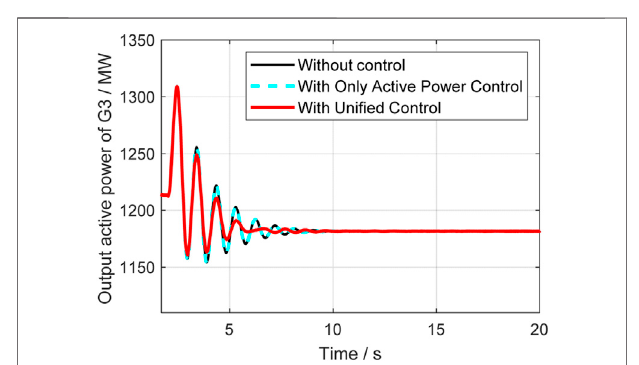
FIGURE 16 | Active power of G3 with different schemes.